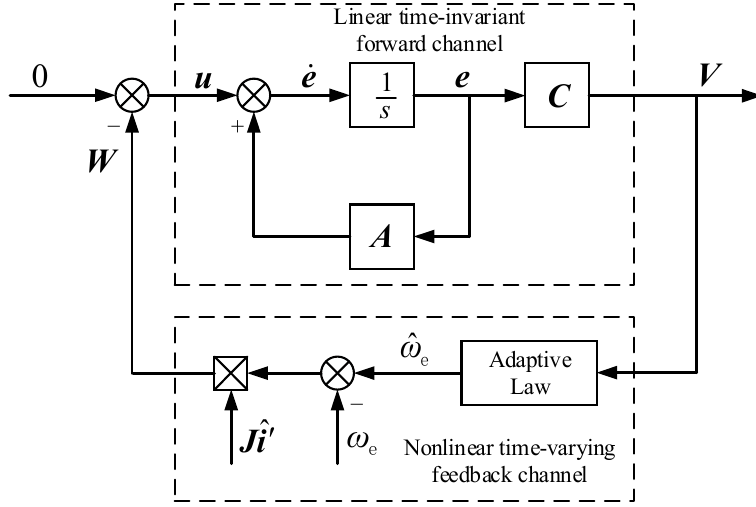
Figure 3. Structure diagram of equivalent nonlinear feedback system.